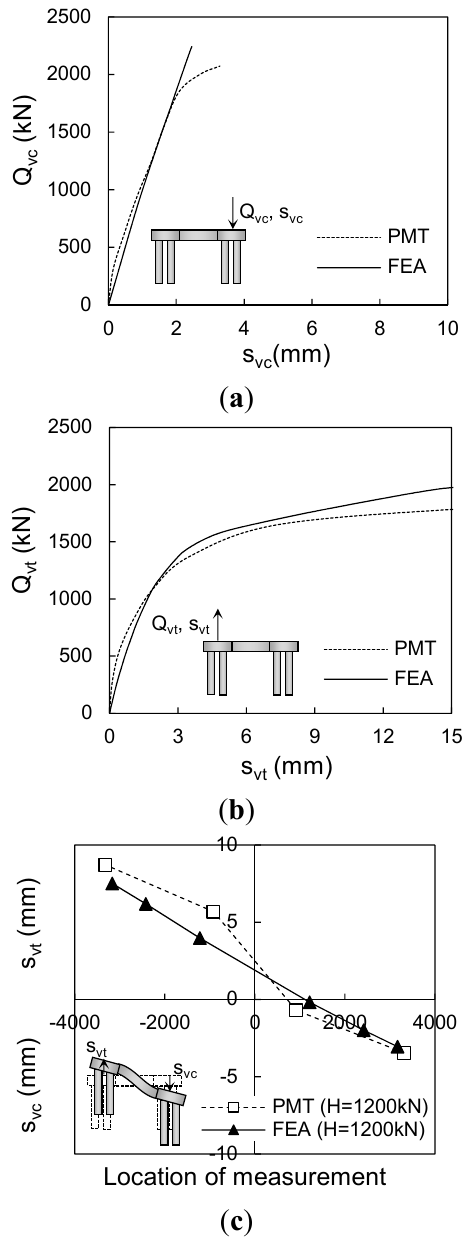
Figure 9. Compared load-displacement curves of prototype model test (PMT) and finite element analysis (FEM): ( a ) compressive load responses; ( b ) uplift load responses; and ( c ) vertical settlement